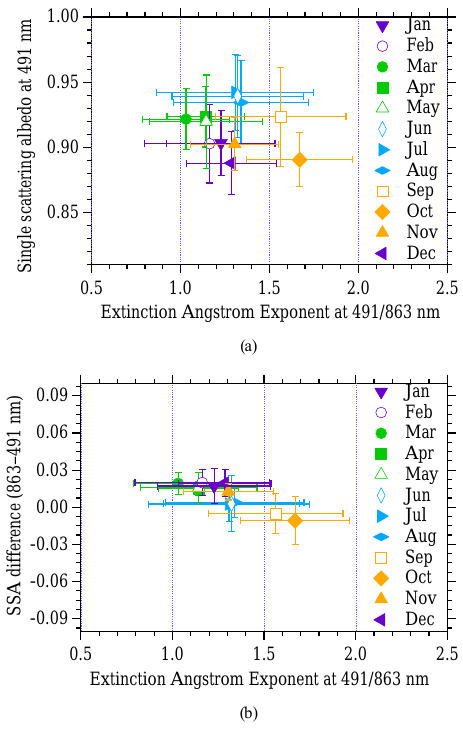
Figure 8. Relationships between the monthly mean values of 491nm SSA and extinction Ångström exponent (EAE) at 491/863nm (a) and between the monthly mean values of the SSA difference (863–491nm) and EAE at 491/863nm (b)